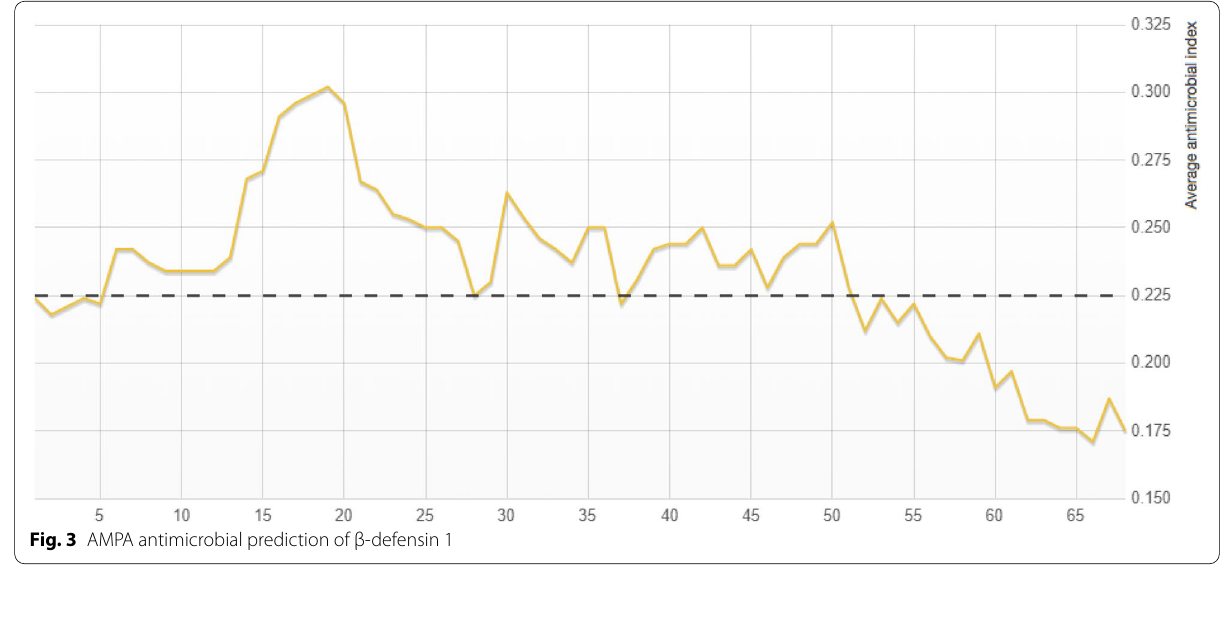
Fig. 3 AMPA antimicrobial prediction of β-defensin 1